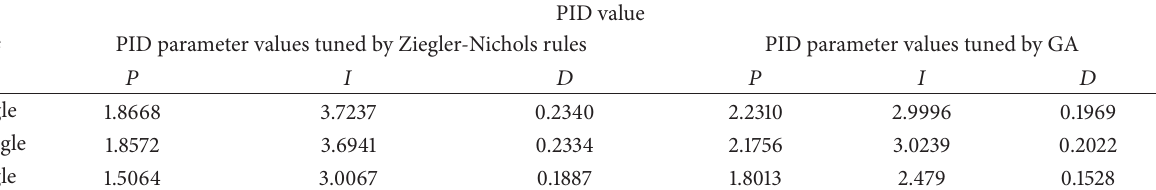
Table 2: PID parameter values tuned by Ziegler-Nichols rules and GA.